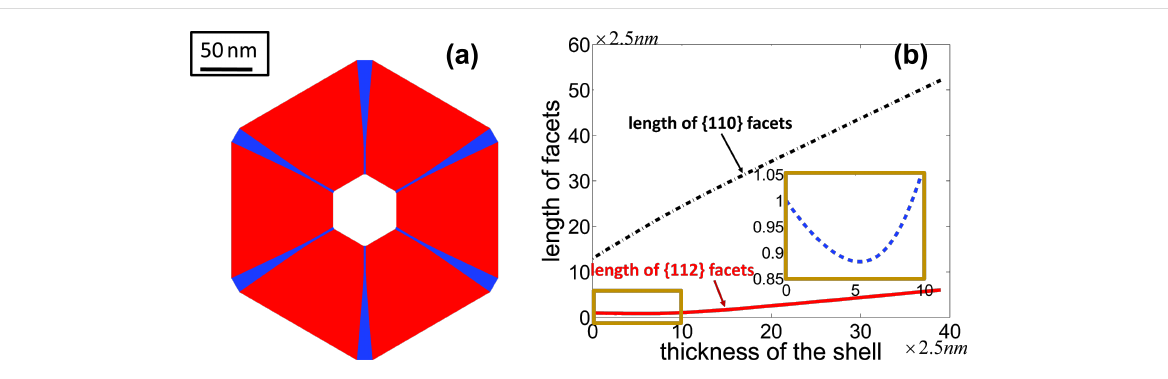
Figure 6: (a) Cross section of the core–shell nanowire with six {112} facets (blue color) along the corners of six {110} facets (red color) in the numeri- cal simulation when the shell of the nanowire is large enough. (b) Evolution of the length of the facets with respect to the thickness of the shell.